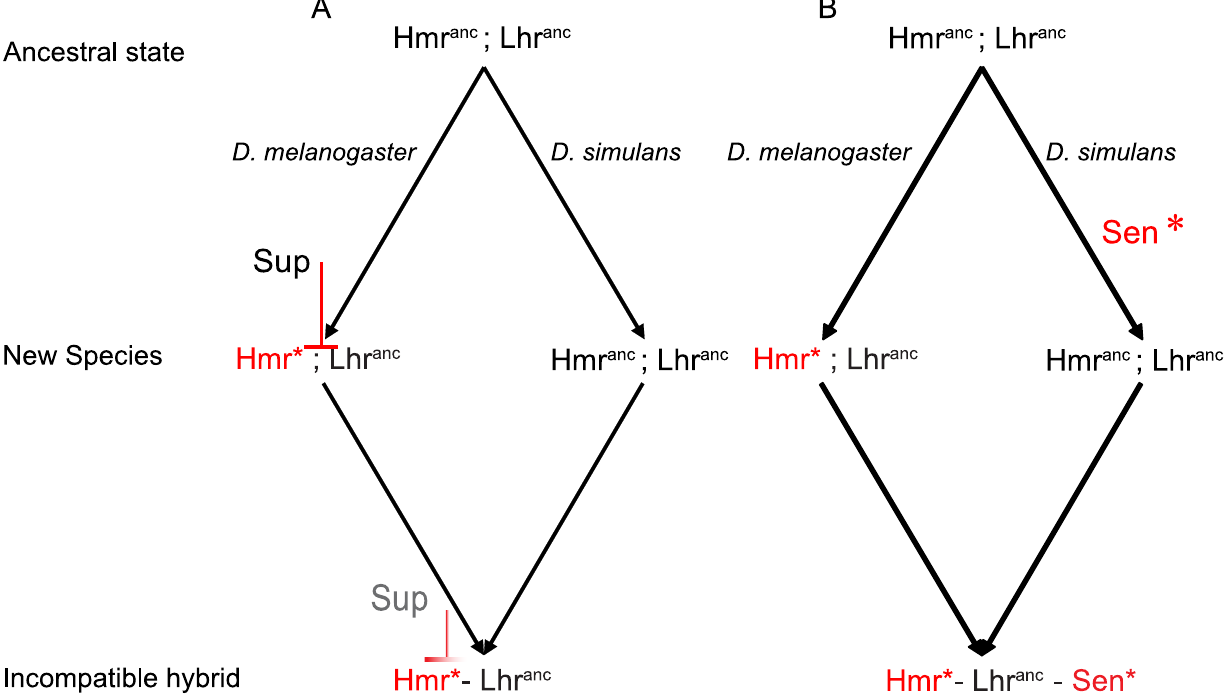
Figure 7. Alternative models for the evolution of hybrid lethality: incompatibility between an evolutionarily derived D. melanogasterHmr and ancestral Lhr . In the first model a suppressor ( Sup ) fixed in the D. melanogaster lineage prevents the two-locus D-M interaction in the pure-species background, but is inactivated or suppressed in the hybrid background. In the second model an additional sensitizing locus ( Sen* ) from the D. simulans lineage is needed to complete the lethal interaction. Additional sensitizing loci could exist in both lineages, leading to a complex multi-genic interaction. The models depicted could involve either direct or indirect physical interactions among genes and gene